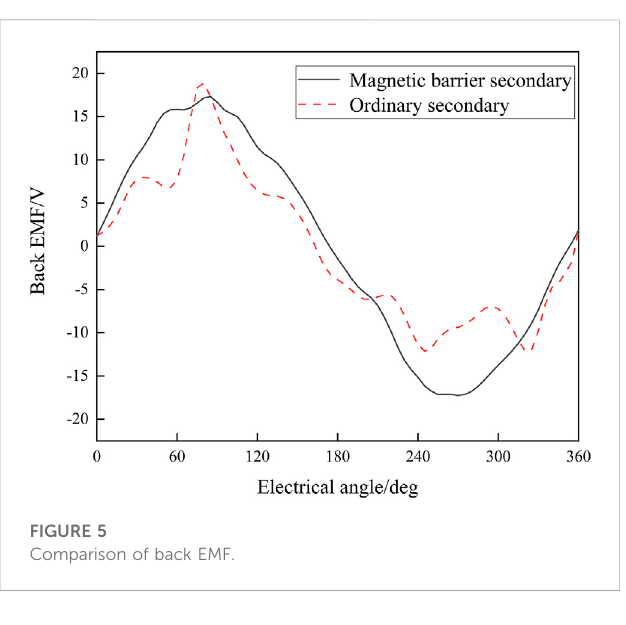
FIGURE 5 Comparison of back